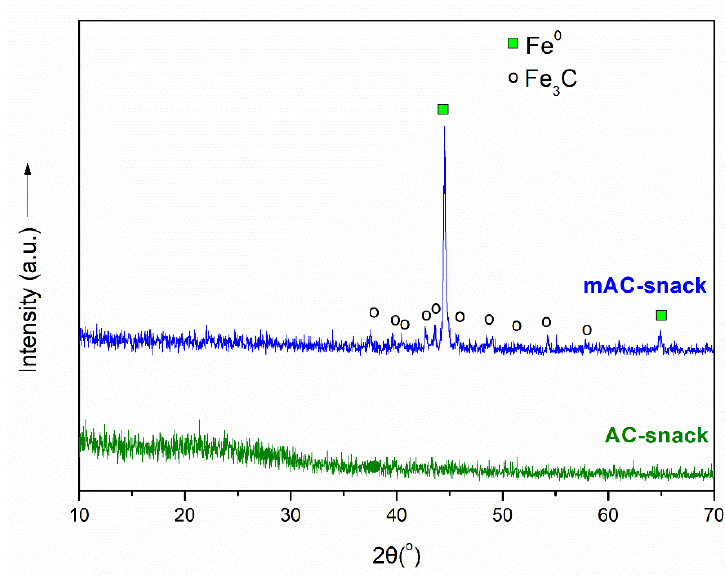
Figure 3. X-ray diffraction patterns the AC-snack and mAC-snack